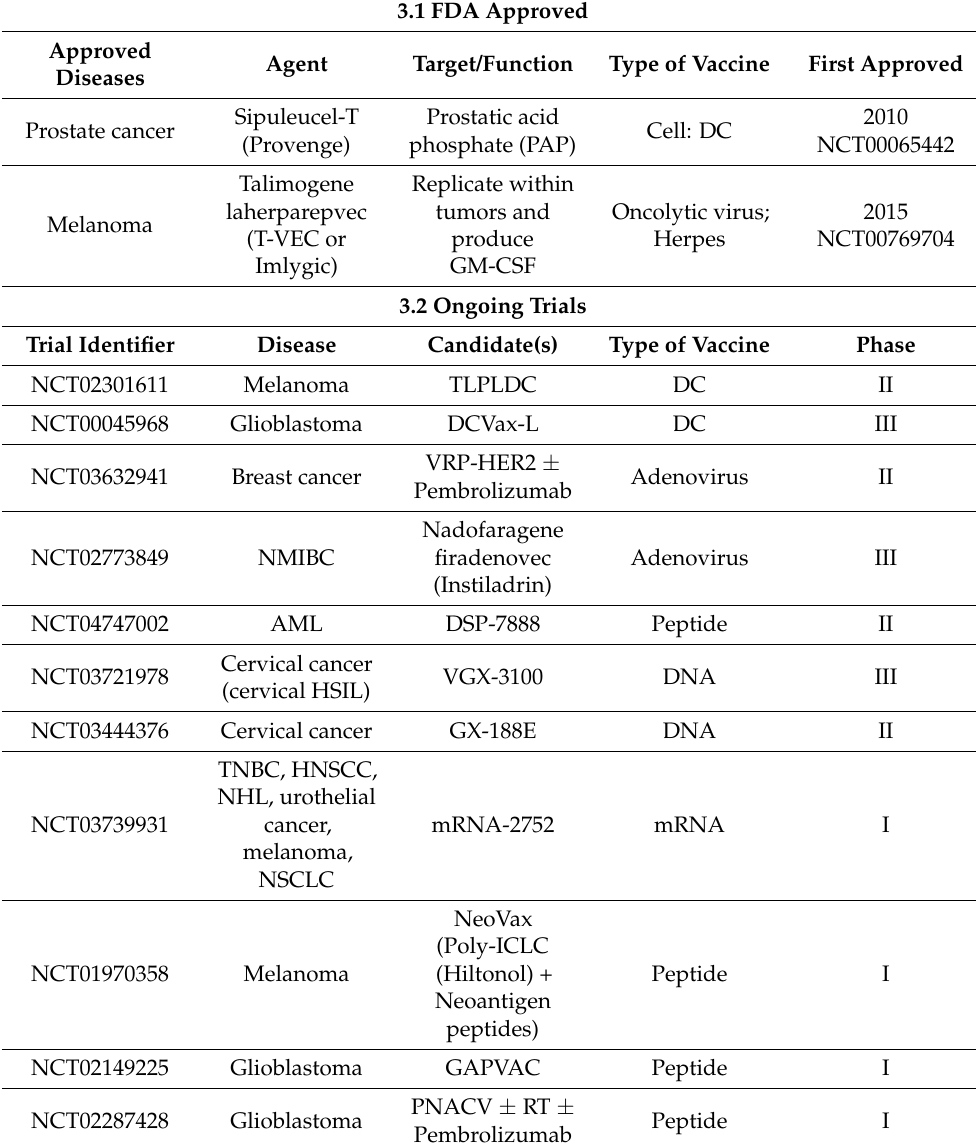
Table 3. FDA approved and examples of ongoing clinical trials for cancer